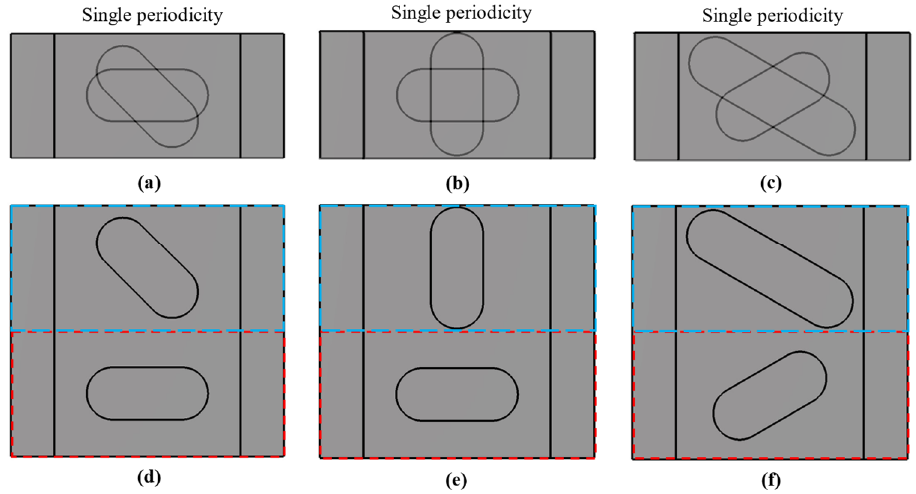
Figure 3. Single periodic configurations for different values of A 1 , A 2 , θ 1 and θ 2 . ( a – c ) Overlapping patterns of the hypothetical base unit cells of the ( d – f ) single periodic unit cells.